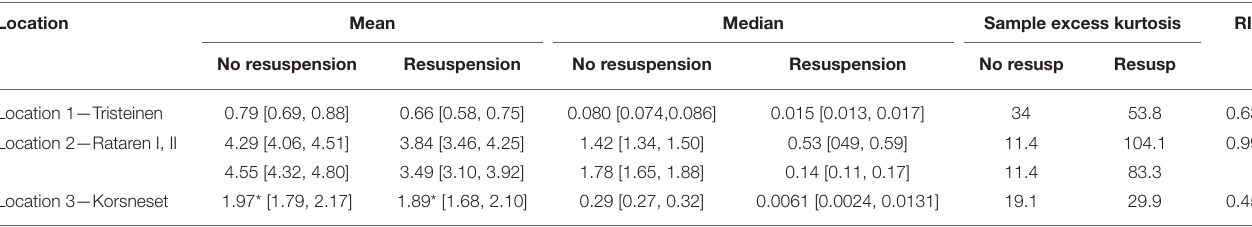
TABLE 2 | Statistics (spatial mean, median, and sample excess kurtosis) for the simulated mud thickness distribution at the time of the MOM surveys ( Table 1 ; Figures 8 , 9 ), for the simulations with and without resuspension, and the RI values for locations 1–3. Location